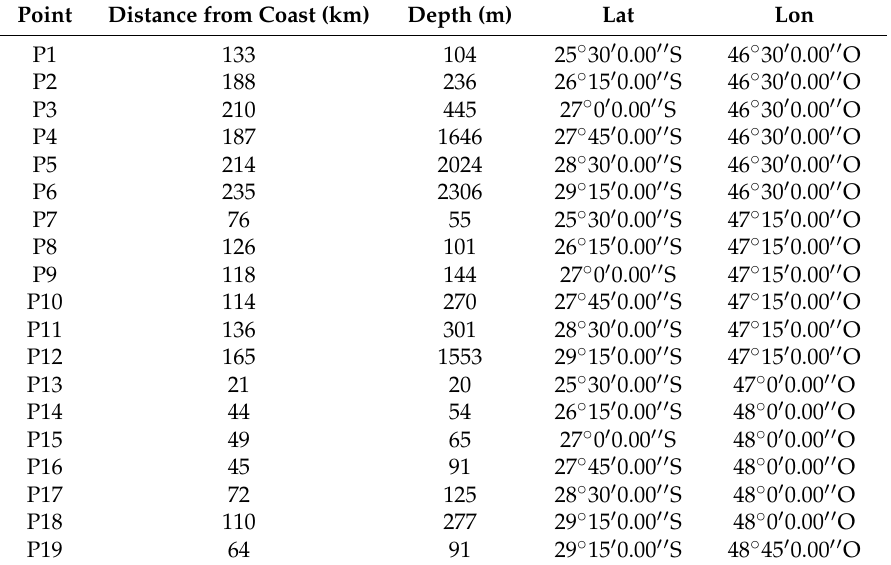
Table 1. Geographical information of European Centre for Medium-Range Weather Forecasts (ECMWF) grid points